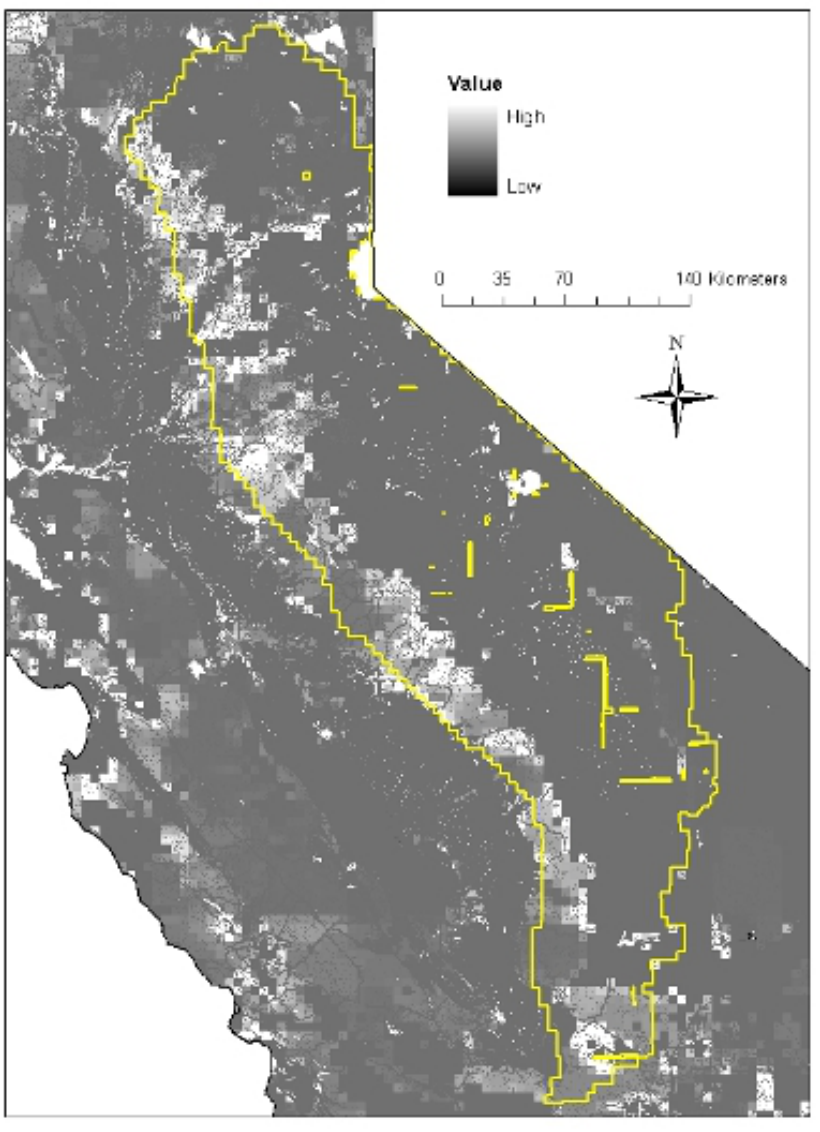
Fig. 5. Modeled threat to California terrestrial biodiversity based on predicted changes in ecological condition because of housing development that would occur between 2000 and 2040 in the absence of conservation interventions. Grid resolution is 1